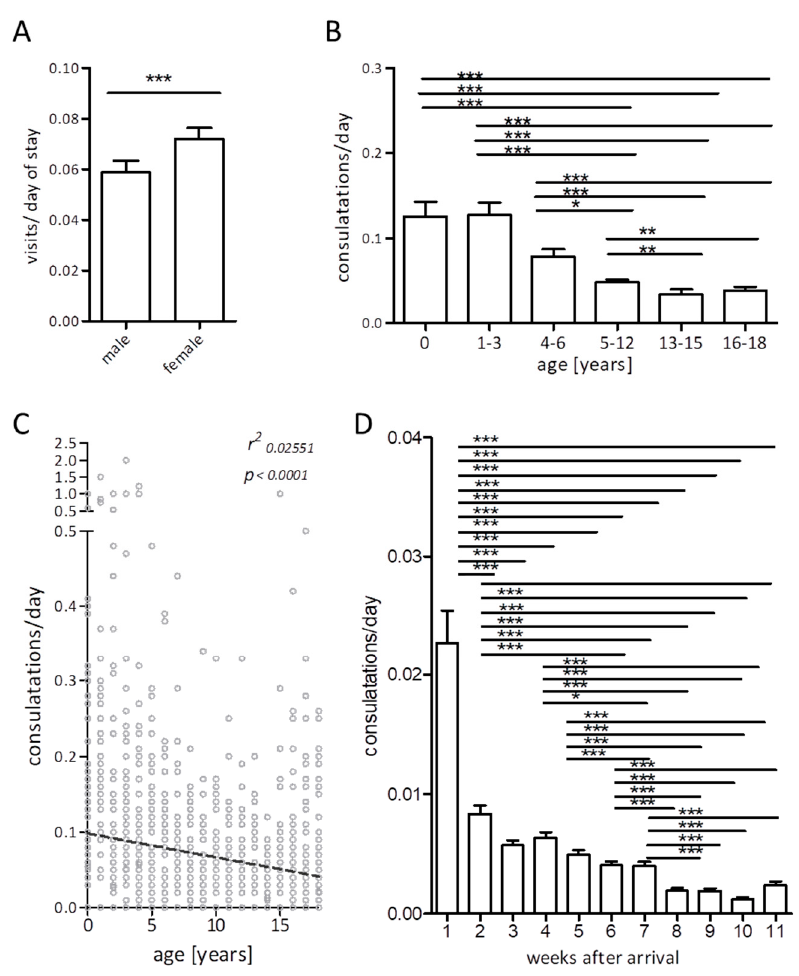
Figure 2. Factors impacting the visit frequencies normalized to day of stay at the refugee residence: Gender ( A ), age ( B , C ), duration of personal stay at the residence (bars display mean + Standard Error of Mean ( A , B , D ), linear regression in ( C ), * p ≤ 0.05, ** p ≤ 0.01 *** p ≤ 0.005).